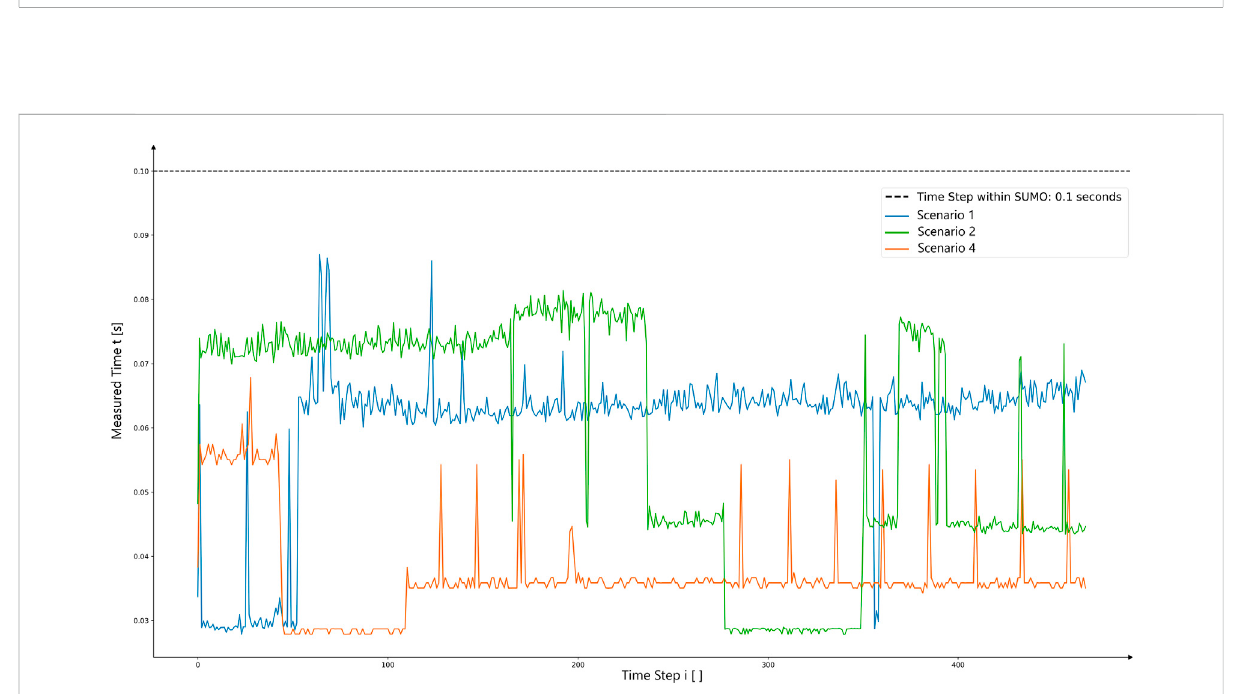
FIGURE 14 Showing the duration of the different controlling steps during the simulation for scenarios 1, 2, and 4 against the time step duration threshold within SUMO, which was chosen to be 0.1